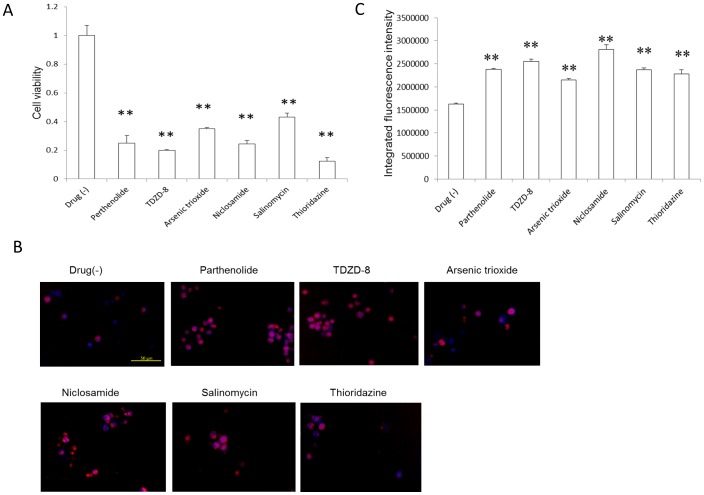
ROS overproduction by the LSC inhibitors.(A) LSC inhibitors (10 µM) significantly inhibited the in vitro proliferation of ALDH+ cells 24 h after treatment (n = 3), **P<0.01. (B) Typical images showing ROS production in ALDH+ cells. LSC inhibitors (10 µM) significantly induced in vitro ROS production in cells treated for 24 h. Blue, nucleus; red, ROS. Scale bar: 50 µm. (C) Quantitative analysis of ROS in the cells (n = 4), **P<0.01.